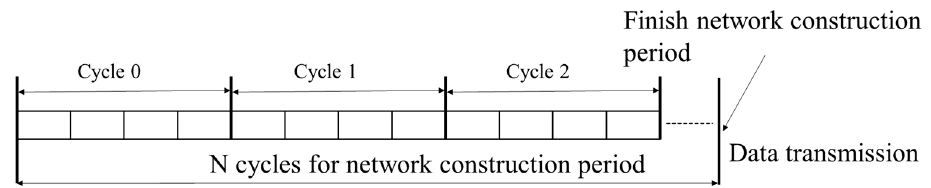
Figure 3. N cycles in the network construction period.